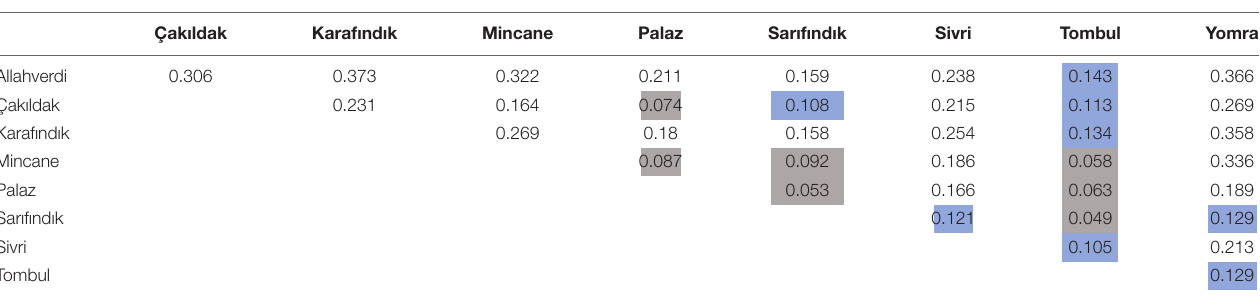
TABLE 3 | Inter-varietal F ST values